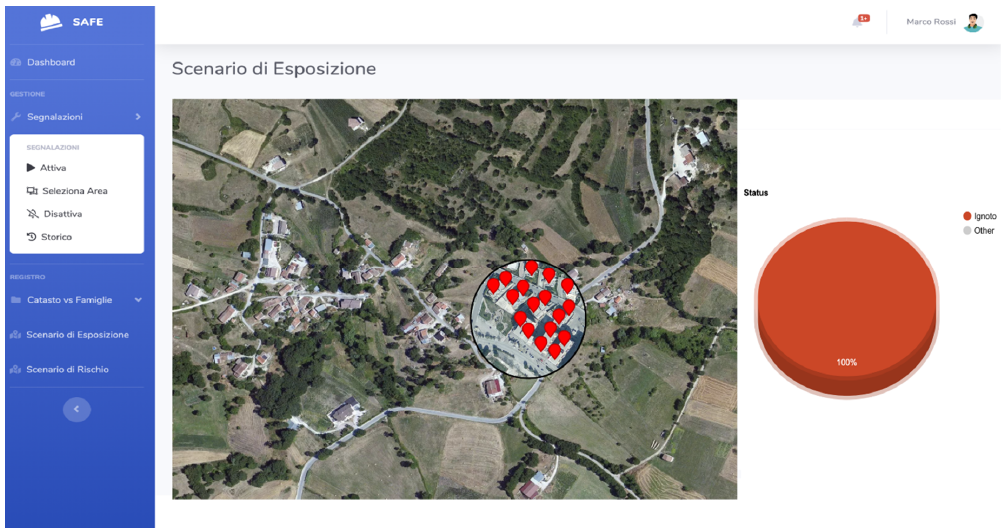
Figure 18. The exposure scenario after launching an alert.